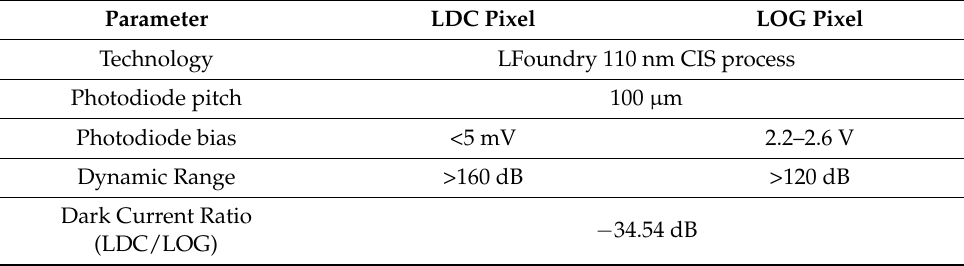
Table 1. Summary of pixel